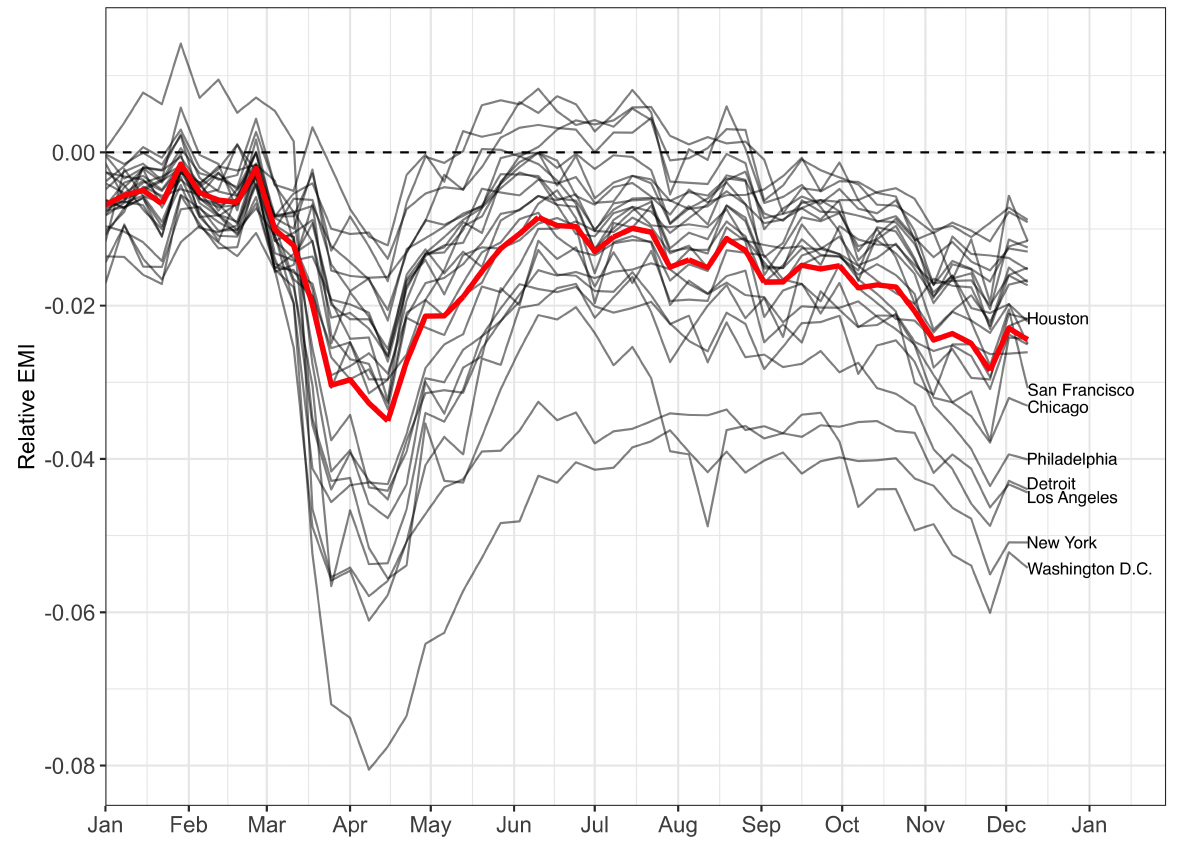
Figure 3: Weekly EMI relative to 2019 average. Each line represents changes in a single city, and the red line is the weekly